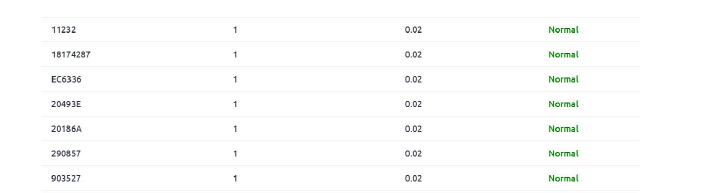
Figure A3. Servuce wrt doctor Rating and status.